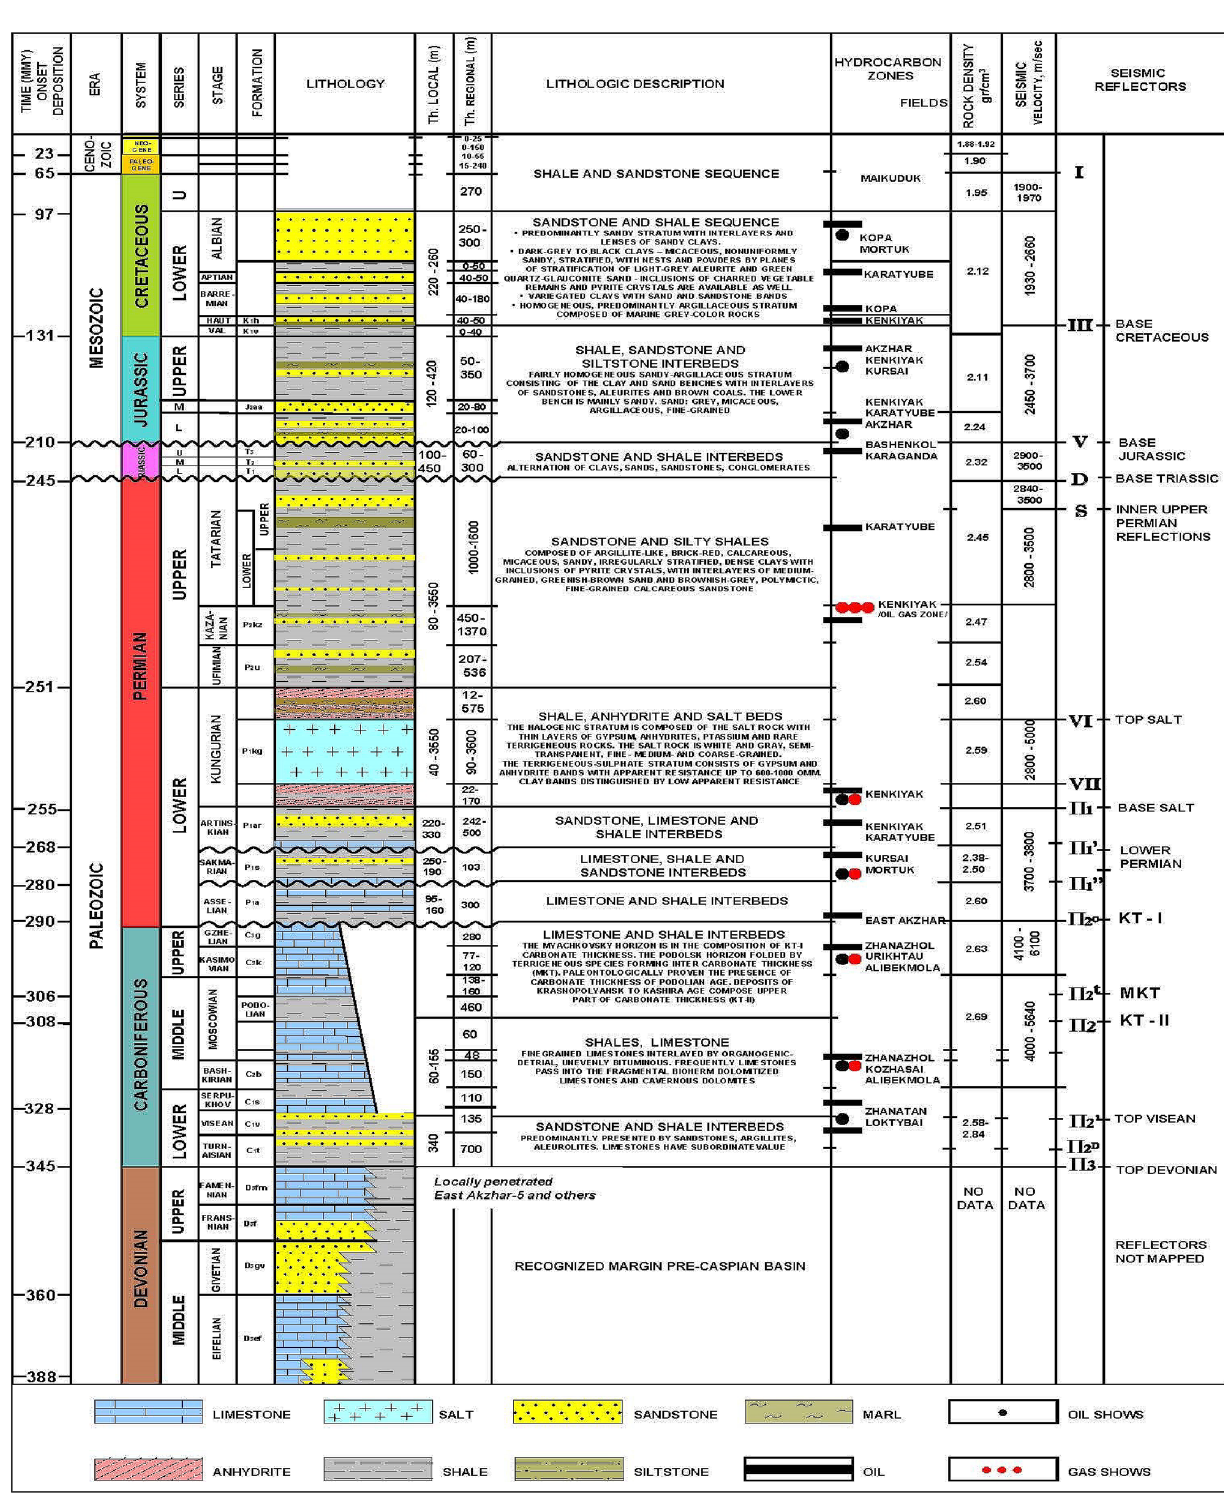
Fig. 3 Generalized stratigraphy column of the eastern boundary of the pre-caspian sedimentary basin (modified from Barde Jean-Pierre et al.